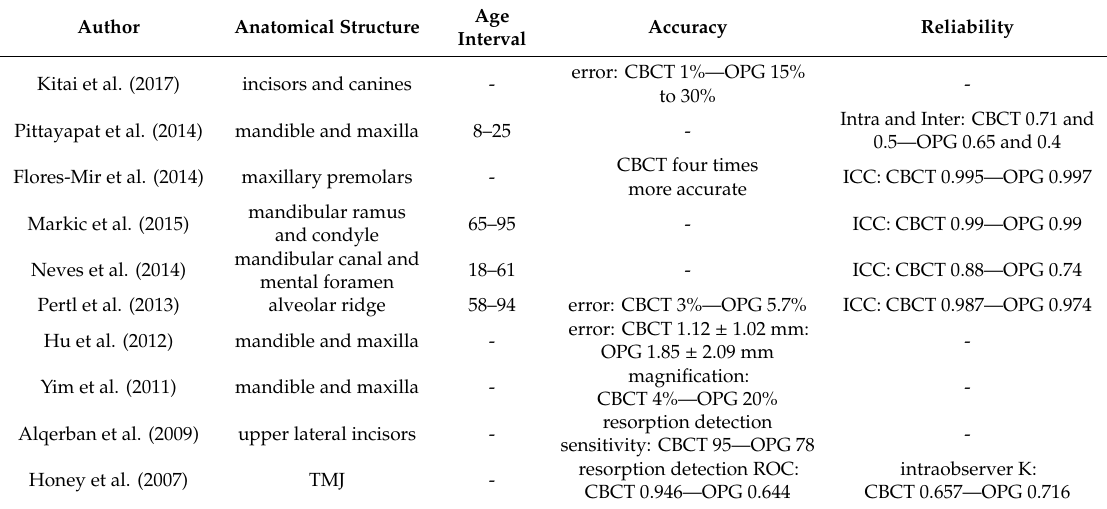
Table 4. Summary of data regarding dental anatomy evaluation.